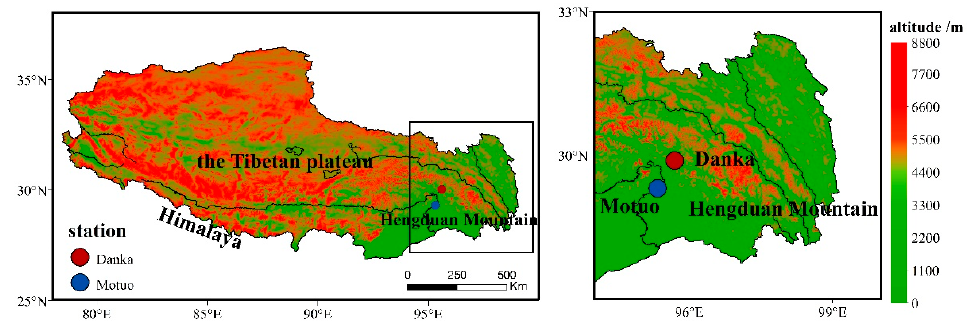
Figure 1. Topography of the study area and locations of the observation sites, Solid dots indicate the site location.